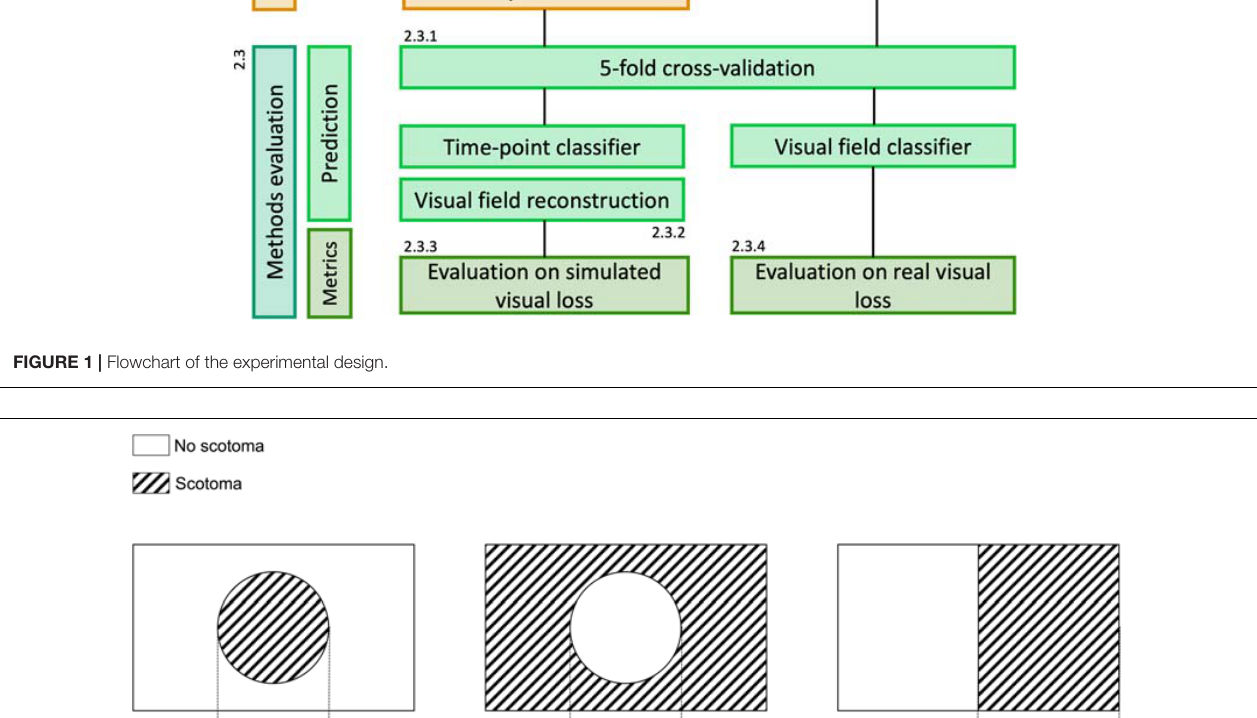
where p ( t ) and s ( t ) are the positions on the screen of the eye and the stimulus, respectively, divided into their horizontal ( x ) and vertical ( y ) components.